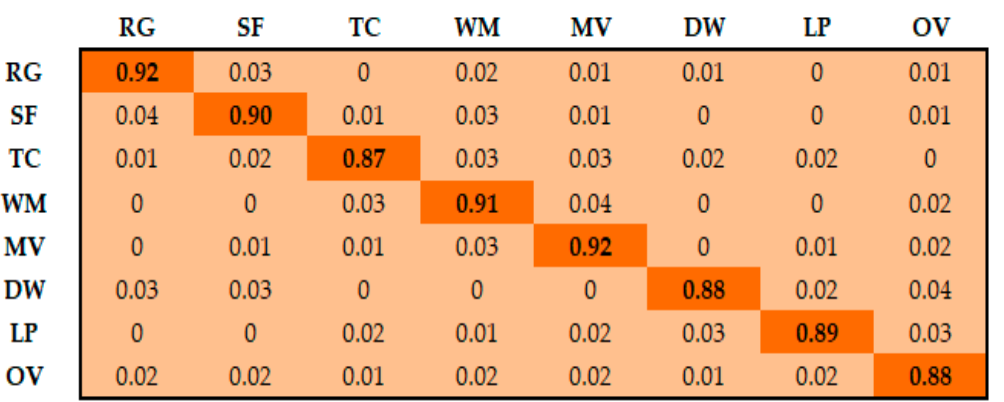
cleaner, PR = play guitar, LS = lay on a sofa.